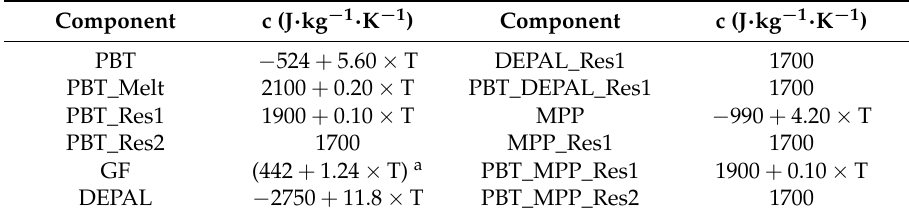
Table 4. Heat capacities of condensed-phase components.